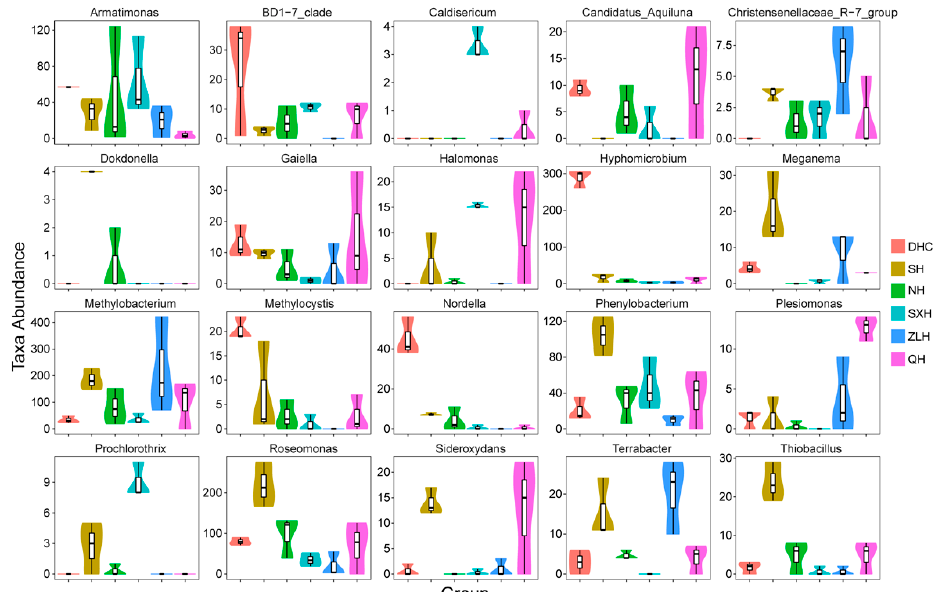
Figure 3. Taxa abundance of different bacteria species in groups DHC, SH, NH, SXH, ZLH and QH, which were sampled from their water.